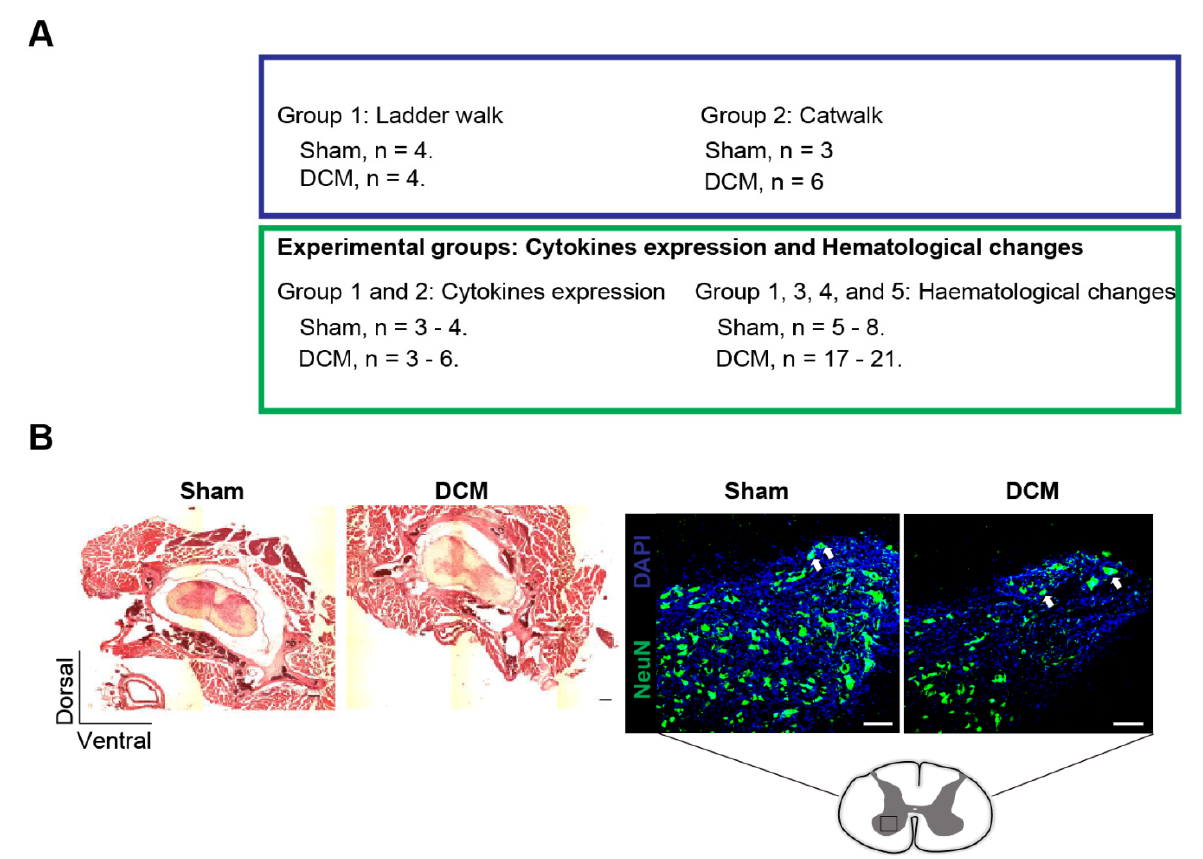
Figure 1. Experimental design and neurological testing. ( A ) Scheme of the experimental design indicating experimental groups and cohorts used for behavioral assessments, hematological changes, and cytokines expression. ( B ) Representative HE-stained coronal sections of the calcified C5-6 area of sham and DCM animals ( left panel ) and NeuN + cells ( right panel ) for the ventral horns. A spinal cord schematic depicting the area of the representative image is shown below. Arrows indicate NeuN + cells. Scale bars = 125 μ m for HE images and 500 μ m for NeuN staining.